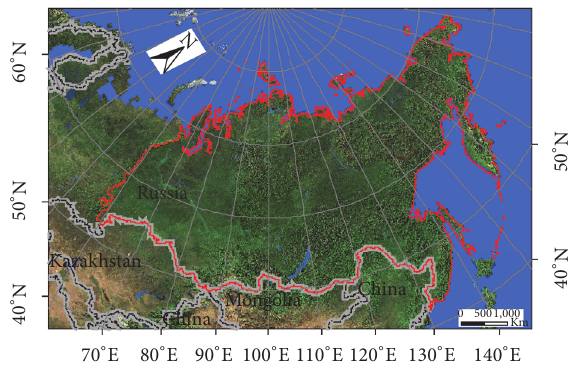
Figure 1: The study area,